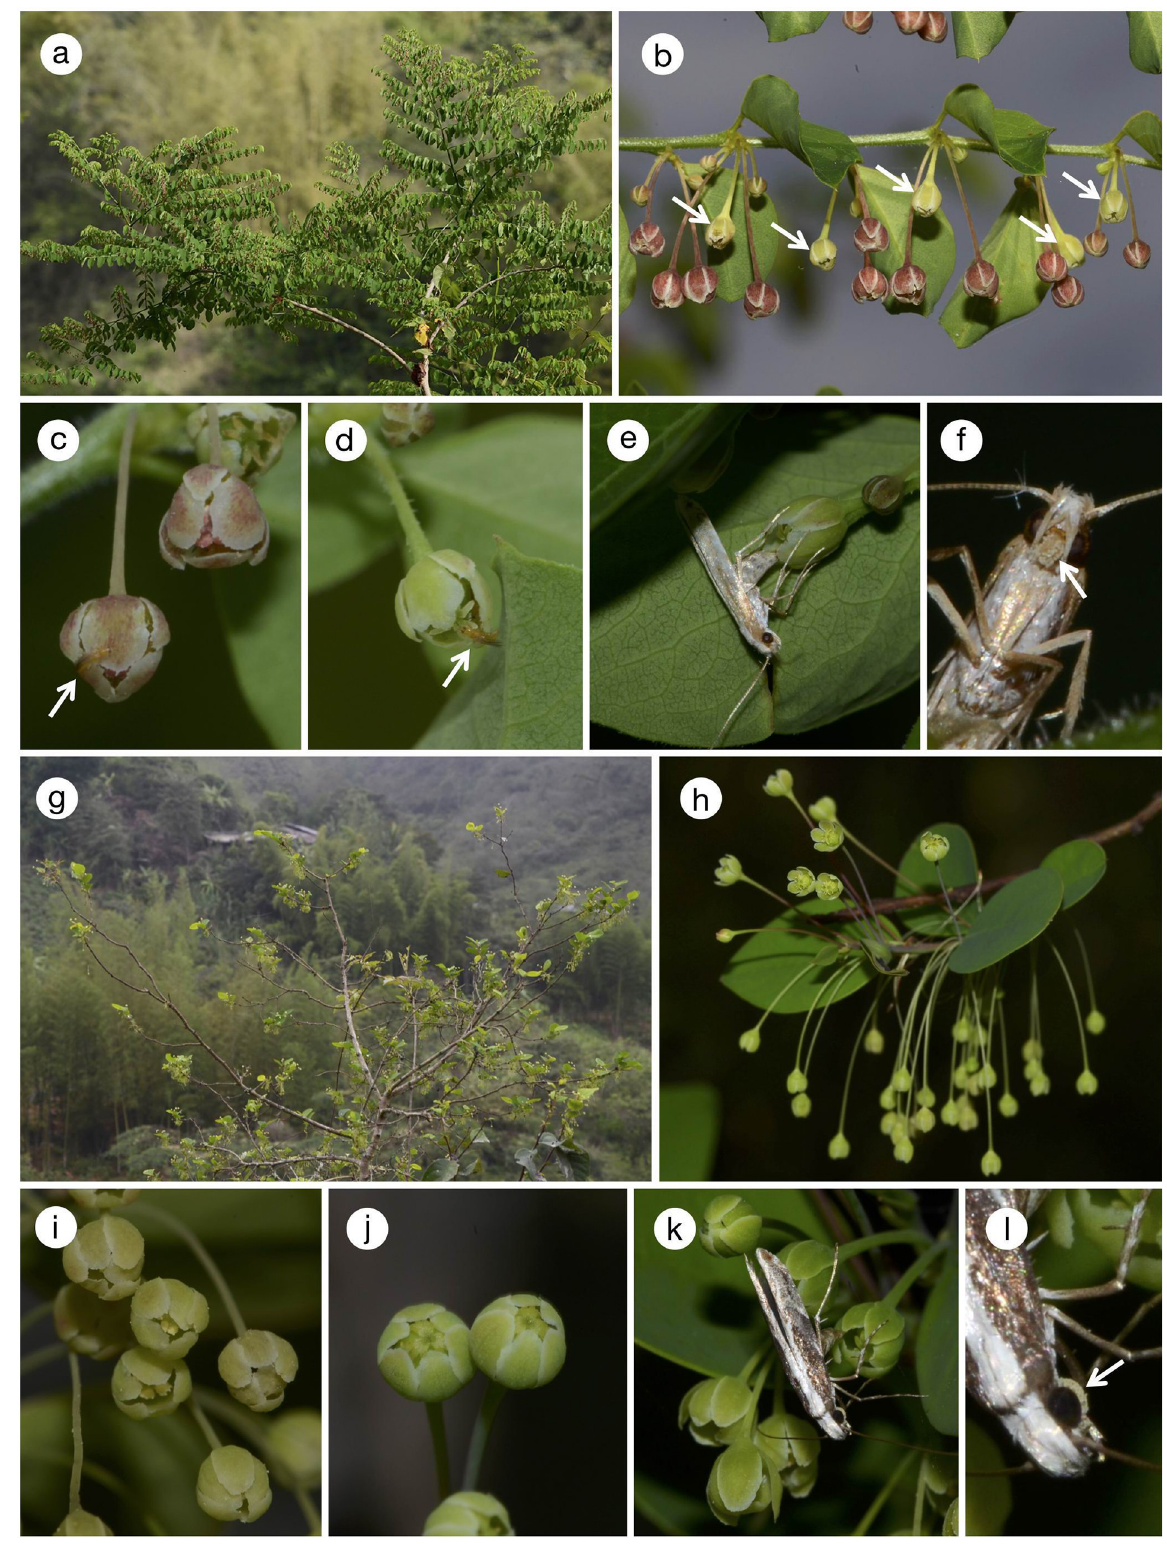
Fig 4. Phyllanthus graveolens , P . huallagensis , and associated insects. (a)–(f) P . graveolens ; (g)–(l) P . huallagensis . (a) Habit; (b) a branch bearing male and female flowers. Female flowers are indicated by arrows, and the rest are all male flowers; (c) male flower visited by a thrips